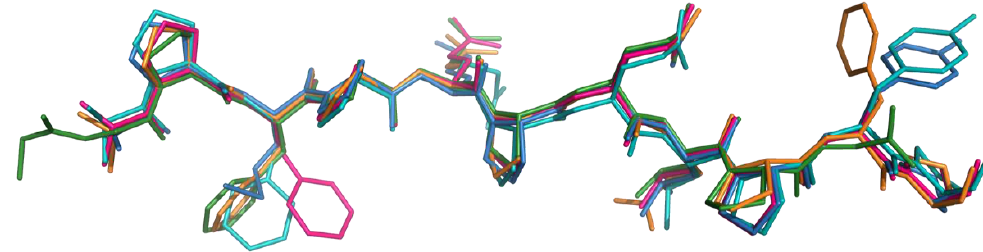
Figure 6. Superimposition of DQ2 α 1 (from binary complex, PDB code 1S9V, forest), DQ2.5-glia- α 1a (from binary complex, PDB code 6MFG, hot pink) DQ2.5-glia- α 1a (from ternary complex, PDB code 4OZI, teal), DQ2.5-glia- ω 1 (from ternary complex, PDB code 6MMF, orange), DQ2.5– P.fluor - α 1a (from binary complex, PDB code 6U3M, blue).